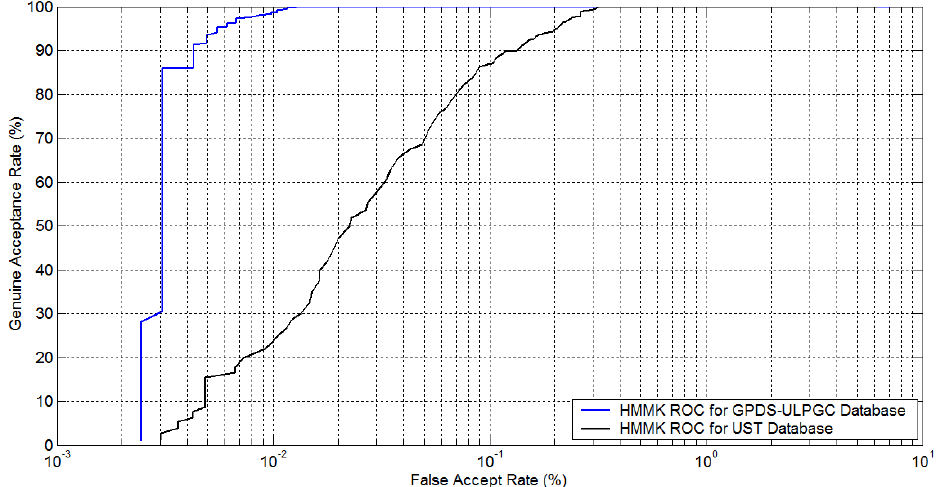
Figure 5. ROC curve for GPDS and UST databases under our best model based on DHMMK using two training samples (better viewed in